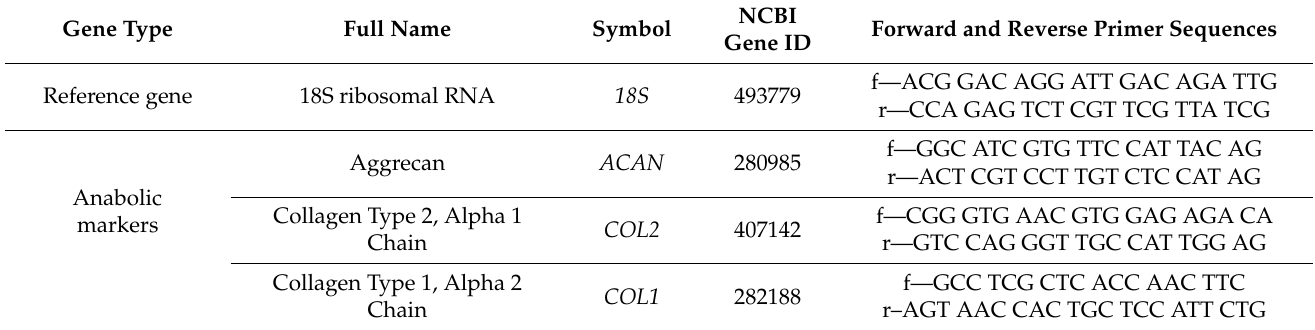
Table 2. Overview of all genes investigated and the primers used with qPCR in this study. Gene